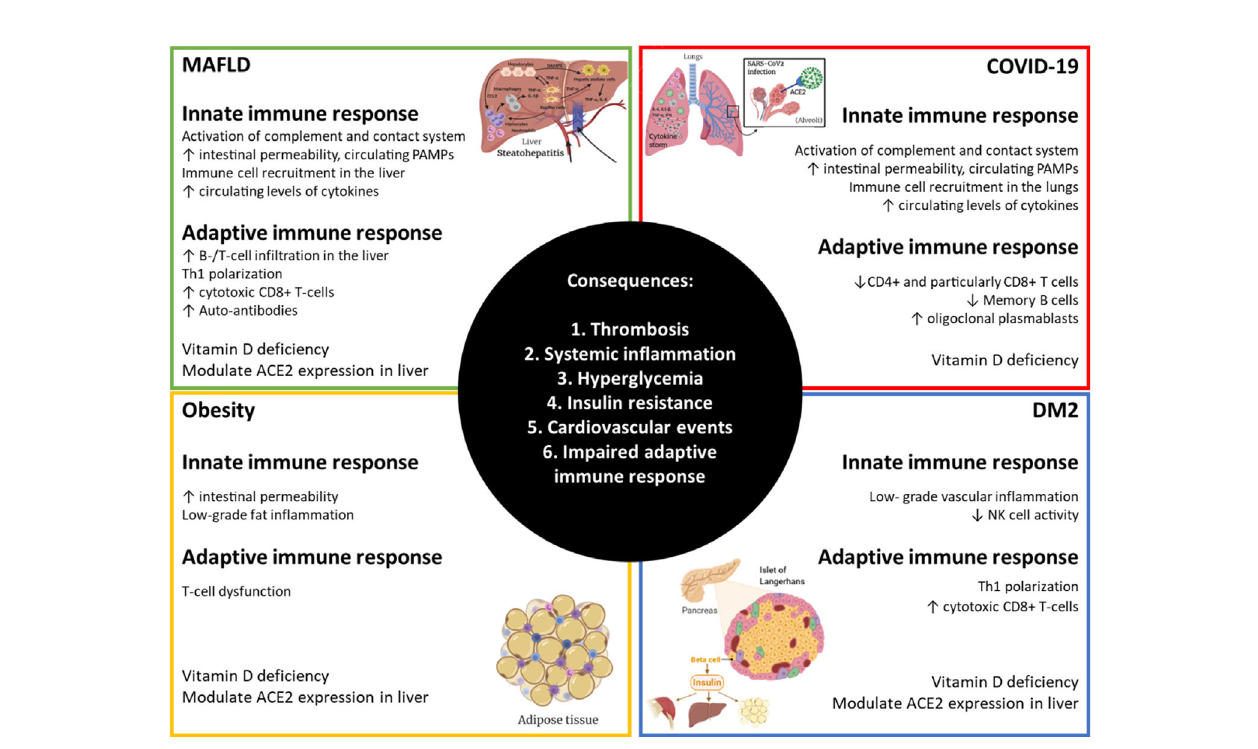
FIGURE 1 | Alterations in immunity that amplify responses to SARS-CoV-2 in MAFLD, obese and DM2 patients. Obesity, diabetes mellitus type 2 (DM2) and metabolic associated fatty liver disease (MAFLD) are very common comorbidities. Each of them has broad effects on the immune system resulting in impairments in normal homeostasis that can lead to more severe COVID-19. Created with